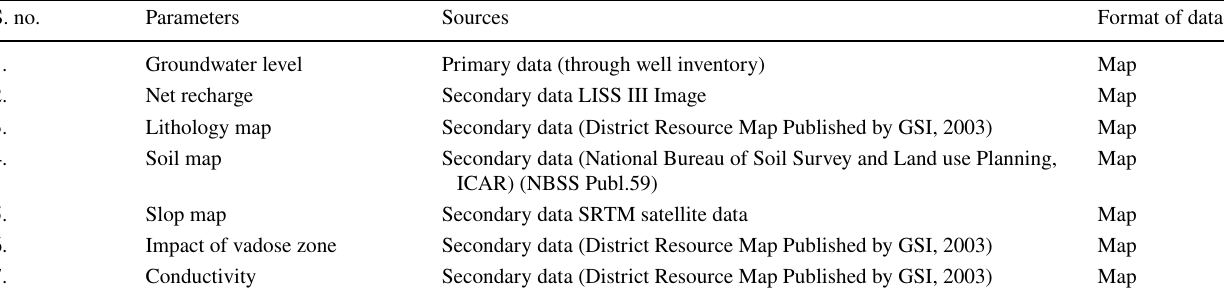
Table 1 Data source and format of data S. no.